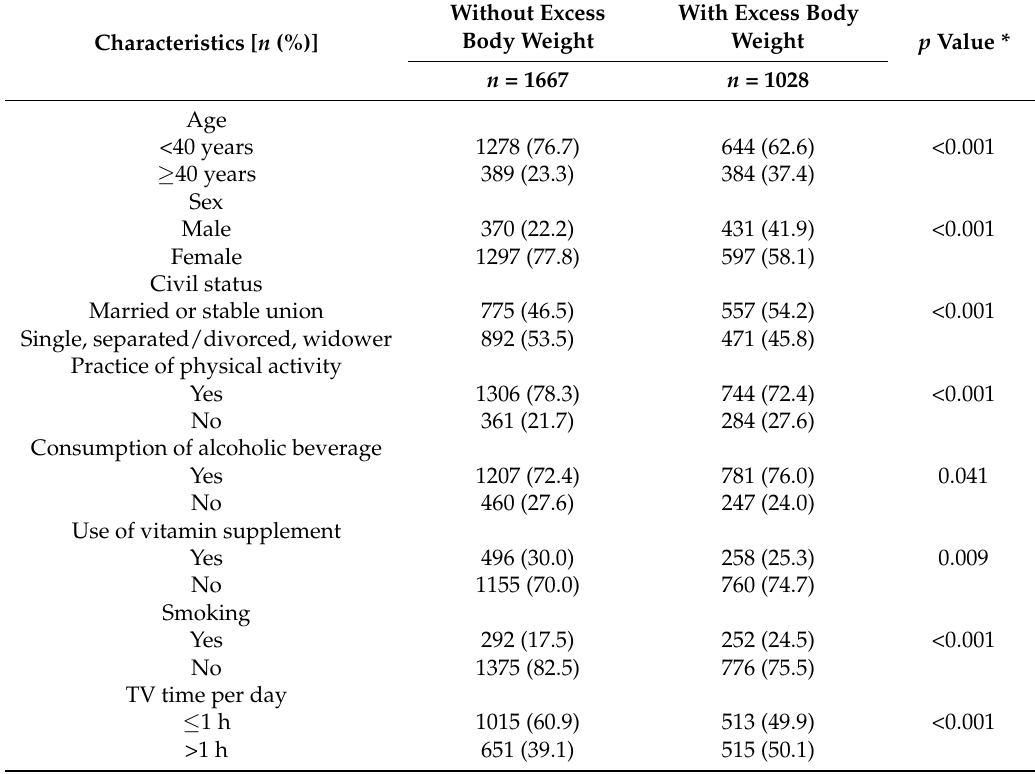
Table 1. Socio-demographic characteristics according to the presence or not of excess body weight † of the CUME project participants ( n = 2695).